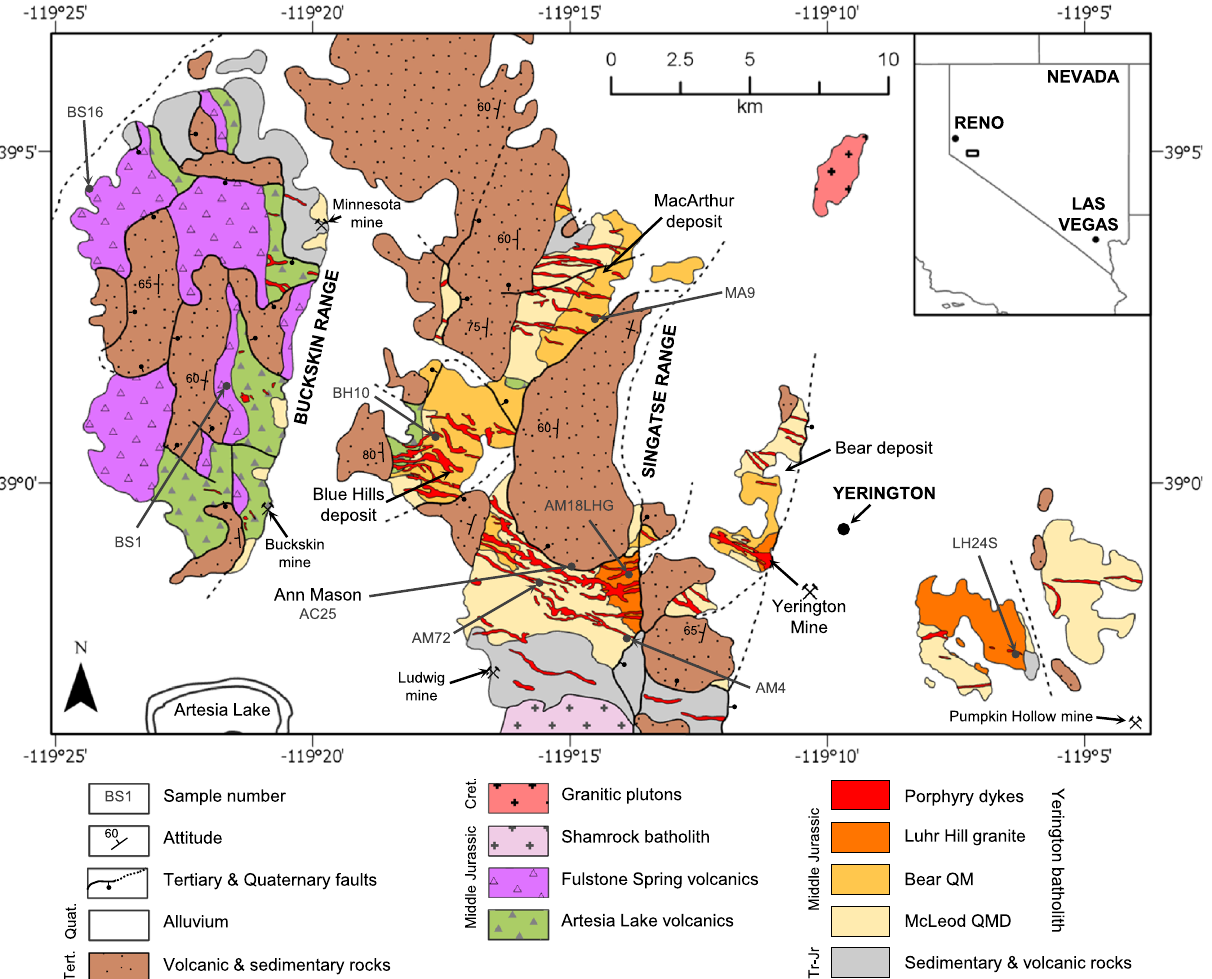
Figure 2. Simplified geological map of the Yerington District, Nevada: annotated with known major mineral deposits and localities sampled for zircon U–Pb CA–ID–TIMS geochronology (Fig. 4). Full sample list in Supplementary Data 1. Geology from 34,35,110 and references therein. QM = quartz monzonite, QMD = quartz monzodiorite. WGS